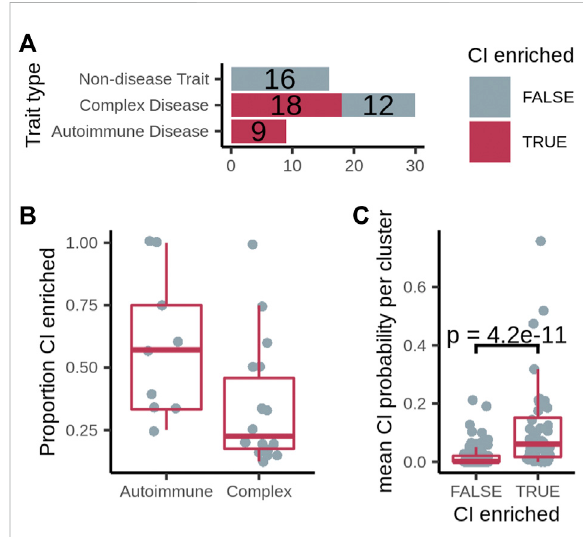
FIGURE 3 (A) Number of diseases/traits with at least one cluster overlappingtheexpandedchronicin fl ammation(CI)geneset(dark pink), out of the total number of diseases/traits. (B) The proportion ofCI-enricheddiseaseclustersamongalldiseaseclustersper disease. (C) Mean probability that genes with no known relationship with chronic in fl ammation residing in a CI-enriched cluster or non-CI-enriched cluster are associated with CI. p -value calculated using a one-sided Fisher ’ s Exact